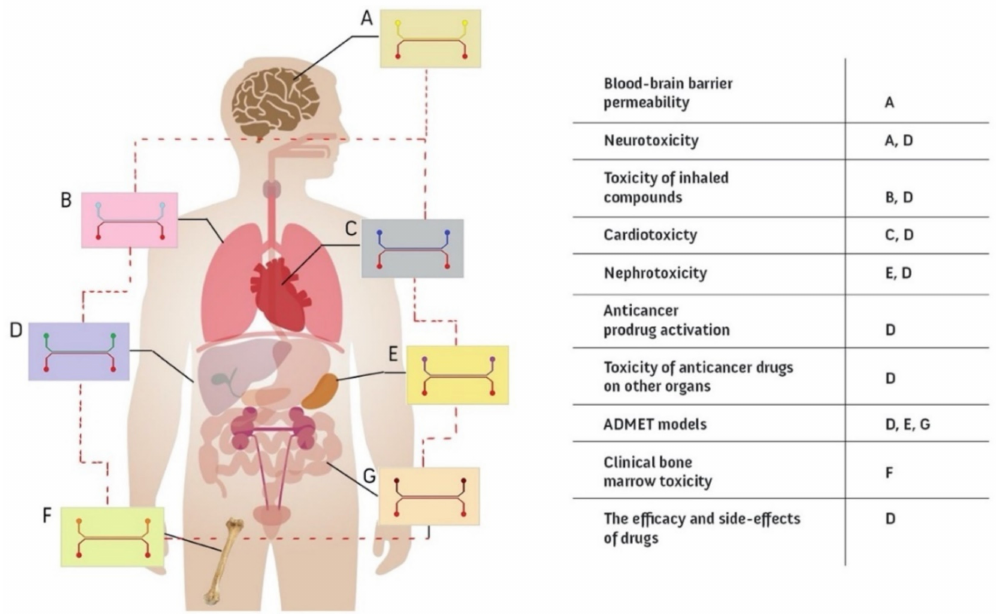
Figure 8. Organ(s)-on-chip; chips recapitulating diverse organs applicable for a wide range of research, including drug efficiency, disease, and ADMET (Adsorption, Distribution, Metabolism, Excretion, and Toxicity)